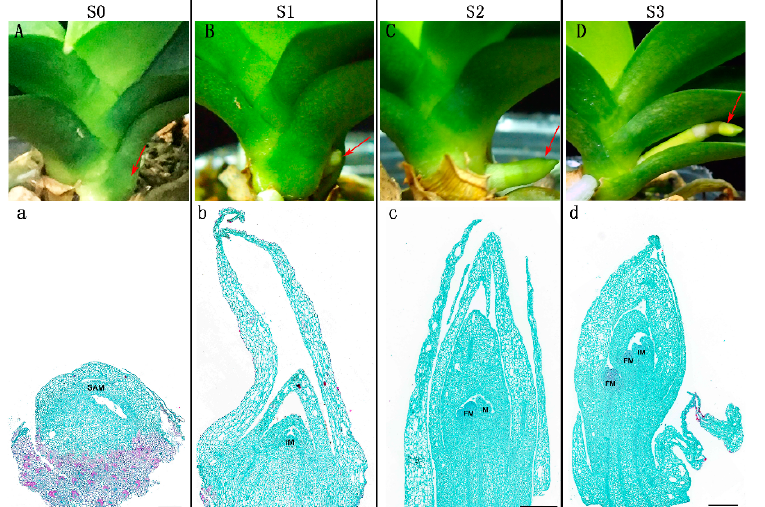
Figure 1. Morphological characterization of the four statuses (S0, S1, S2, and S3) of spike development in Phalaenopsis . ( A ) S0: the axillary bud was embedded in leaf axils and remained dormant. ( B ) S1: the spike was 0.5 cm in length. ( C ) S2: the spike was 1 cm in length. ( D ) S3: the spike was 3 cm in length. ( a – d ) Paraffin sections of bud/spike tip tissues at the four statuses. Arrows indicate the samples used for paraffin section preparation, transcriptome analyses, and endogenous hormone analysis. SAM: shoot apical meristem, IM: inflorescence primordium, FM: floret primordium. Scale bars in ( a – d ) = 500 μ m.